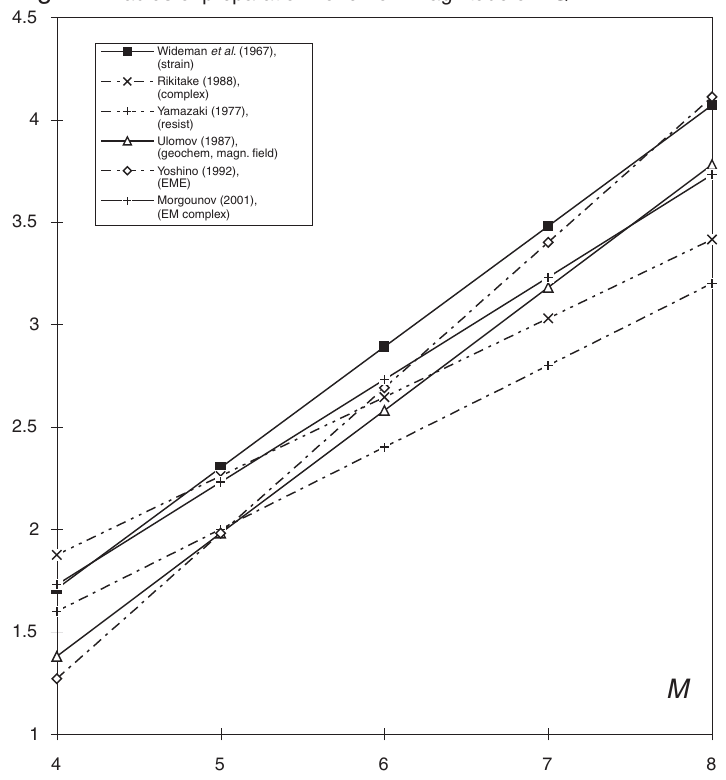
Fig. 1. Log R * - M relationships for precursory anomalies in various fields: strain steps (Wideman et al. , 1967); a summary of all available precursory data including strain, tilt, hydrogeochemical variations, microearthquakes, magnetic field, telluric currents, electromagnetic emission, and electrical resistivity (Rikitake, 1988); variome- ter data on the electrical resistivity (Yamazaki, 1977); geochemical and magnetic fields (Ulomov, 1987); elec- tromagnetic emission (Yoshino et al. , 1992); and summarized electromagnetic data (Morgounov,